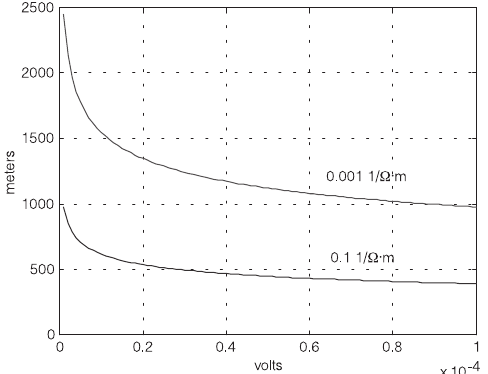
Fig. 4. Diffusion depth of a transient EM plane wave versus threshold of